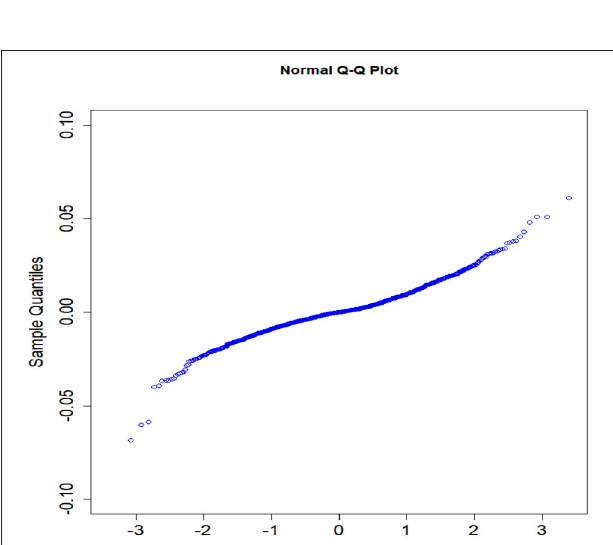
FIGURE 5 | Q-Q plot of Ping An